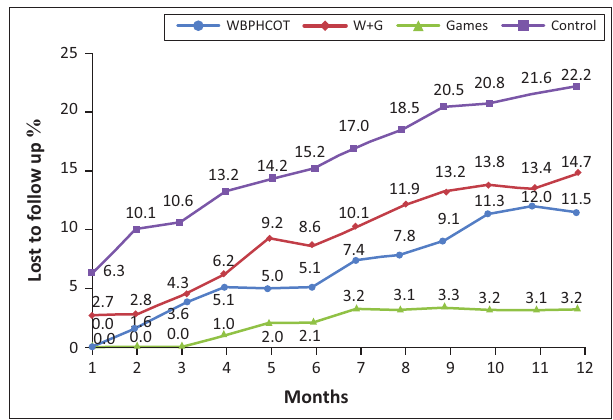
FIGURE 3: Monthly lost to follow-up rate (according to the binary